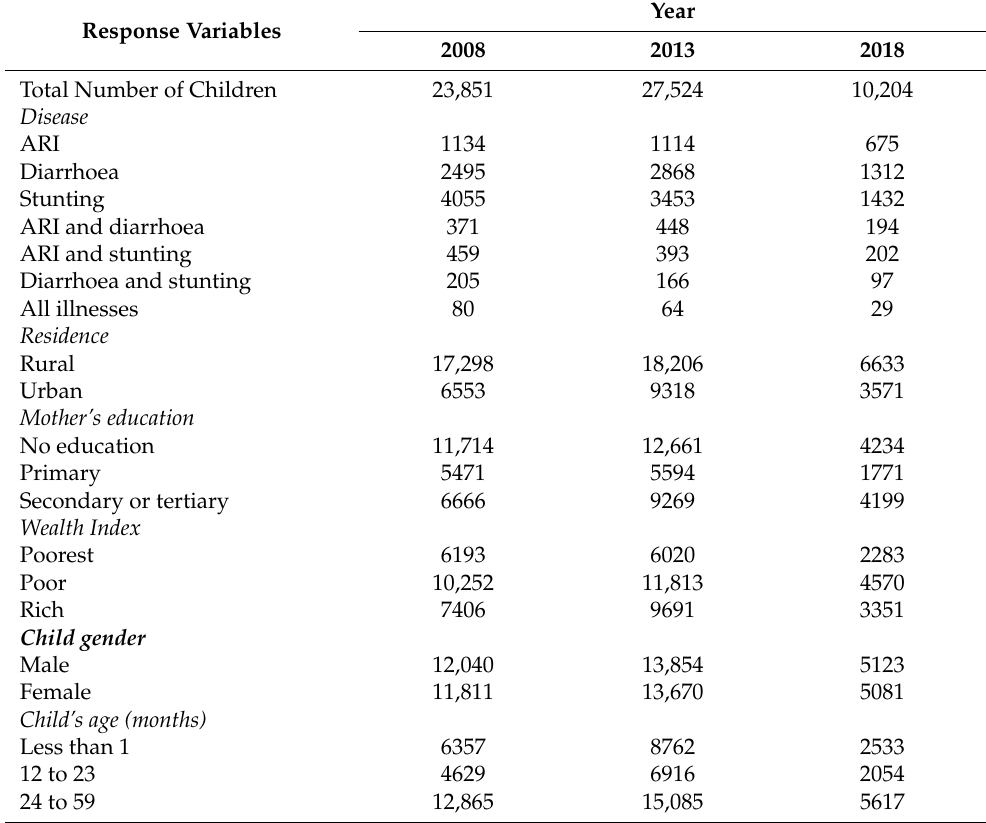
Table 2. Characteristics of the study population.